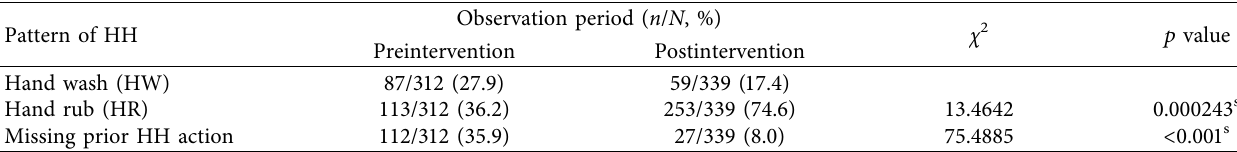
Table 2: Changes in the pattern of hand hygiene